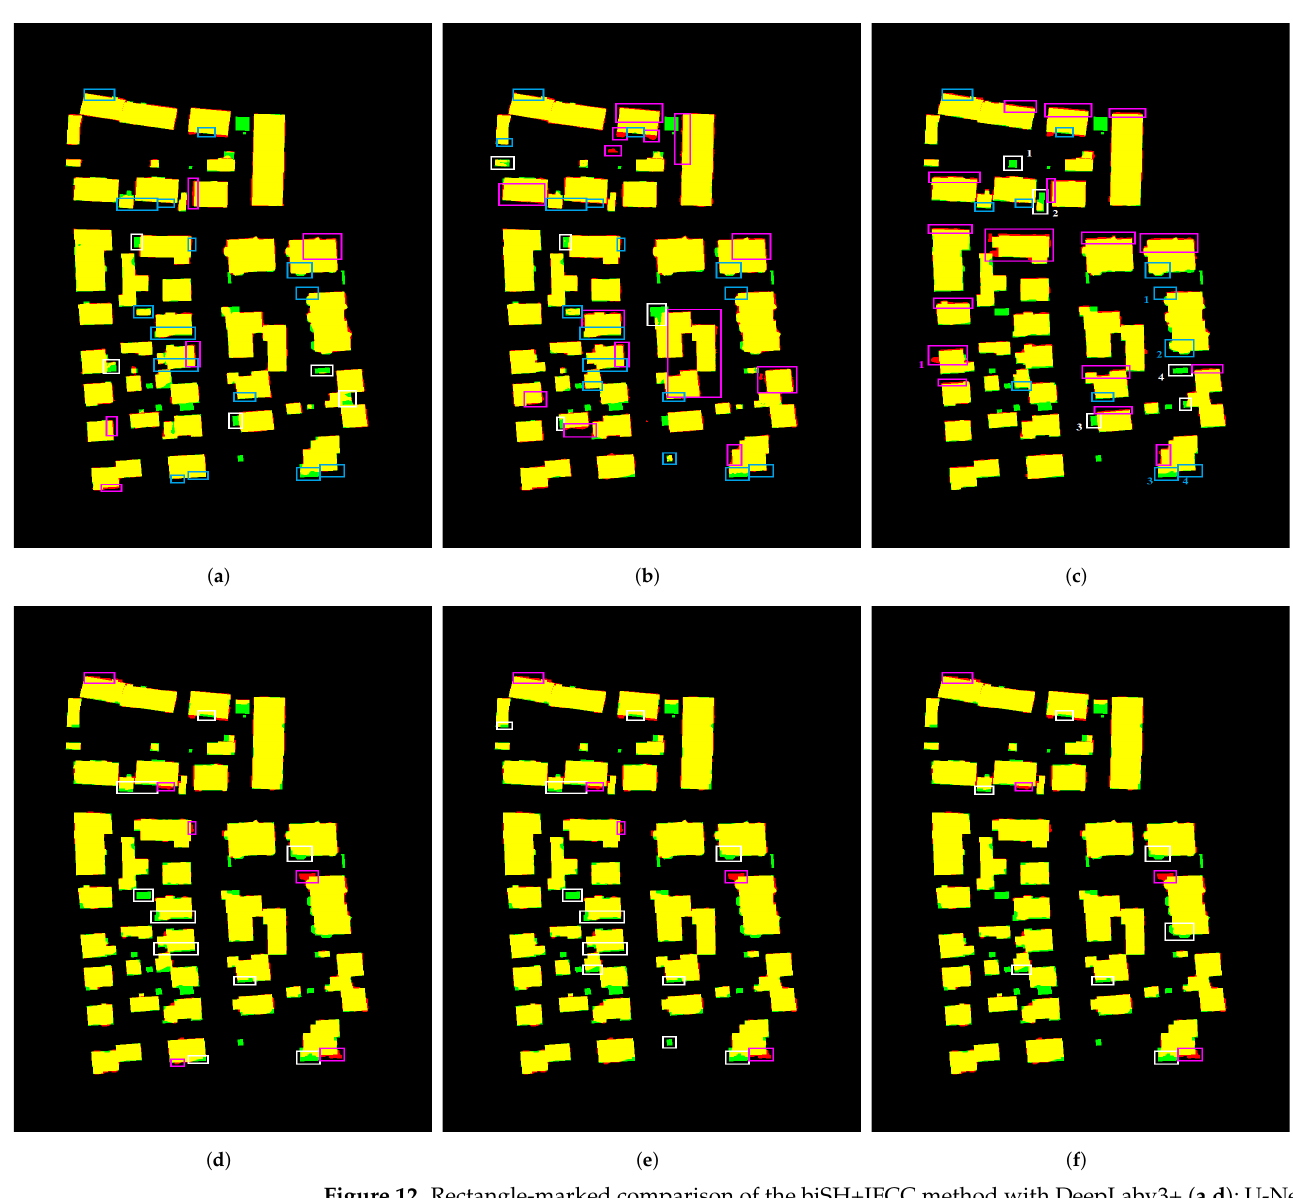
Figure 12. Rectangle-marked comparison of the biSH+IFCC method with DeepLabv3+ ( a , d ); U-Net ( b , e ); and the HOA method ( c , f ) on the third test area. In ( a – c ), the rectangles are drawn on the results of the compared methods, while in ( d – f ), the rectangles are drawn on the result of the biSH+IFCC